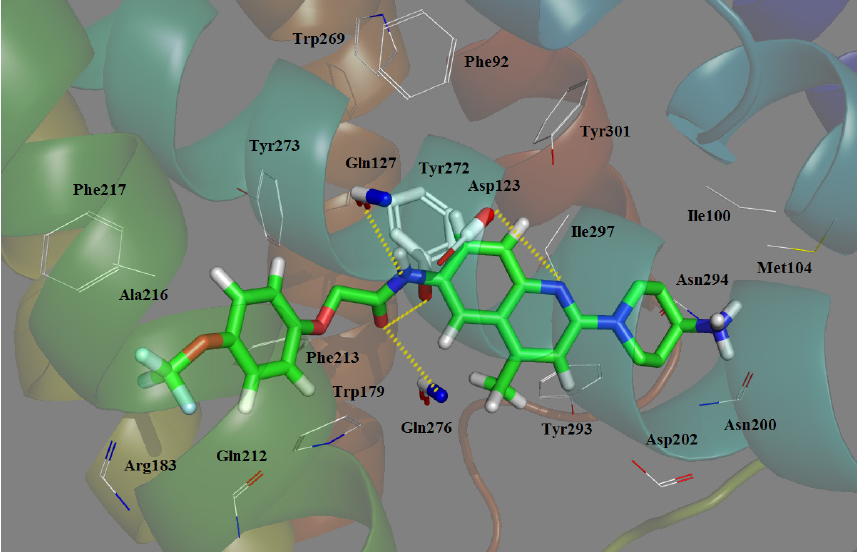
Figure 9. Plot of the in-lipid MD-simulated structures of the binding site. Compound 169 and interaction groups of the crucial amino acids are represented in sticks and highlighted with green and white carbons, respectively. Hydrogen bonds and salt bridge are shown as yellow dashed lines. Atoms O and N are colored with red and blue,